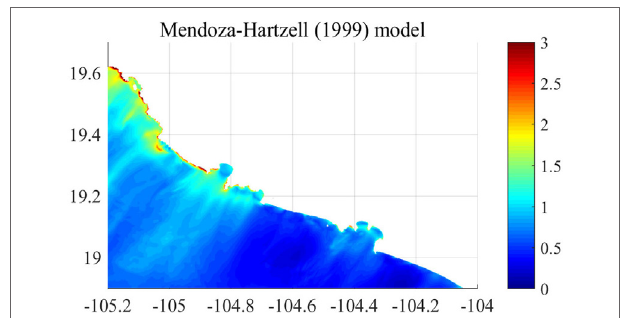
FigUre 9 | Ratio of average maximum surface elevation by the stochastic model considering prediction errors of the scaling relationships to maximum surface elevation calculated based on the Mendoza–Hartzell